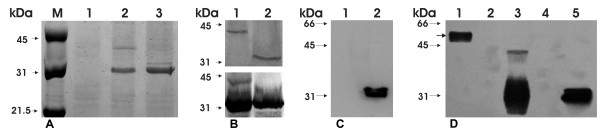
Purified virions are immunogenic. Staining with Comassie Brilliant Blue (A) of mock-inoculated control plants (A1), partially purified viral particles of the PVX6HisE212ACP (A2) and PVX6His2ACP (A3). Western blotting with anti-6His (B upper) and anti-CP (B lower) antibodies of partially purified viral particles of the PVX6HisE212ACP (B1) and PVX6His2ACP (B2). Western blotting analysis (C) using sera from rabbit inoculated with PVX6His2ACP against proteins purified from mock-inoculated control plants (C1) and from PVX6His2ACP (C2). Western blotting analysis (D) using sera from rabbit inoculated with PVX6HisE212ACP. Purified E2 protein (D1; E2 control protein is indicated with a bold arrow), marker (D2), proteins purified from plants inoculated with PVX6HisE212ACP (D3), mock-inoculated control plants (D4) and PVX6His2ACP (D5). Standards Molecular weight (kDa = kiloDaltons) are shown on the left of each figure.